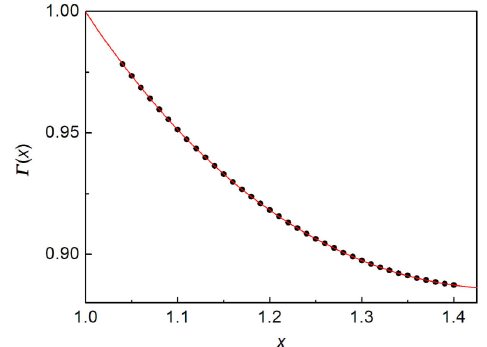
Fig. 8 ( ) Γ x as a function of x . Symbol: individual ( ) x  value; line: the best-fit result of the data